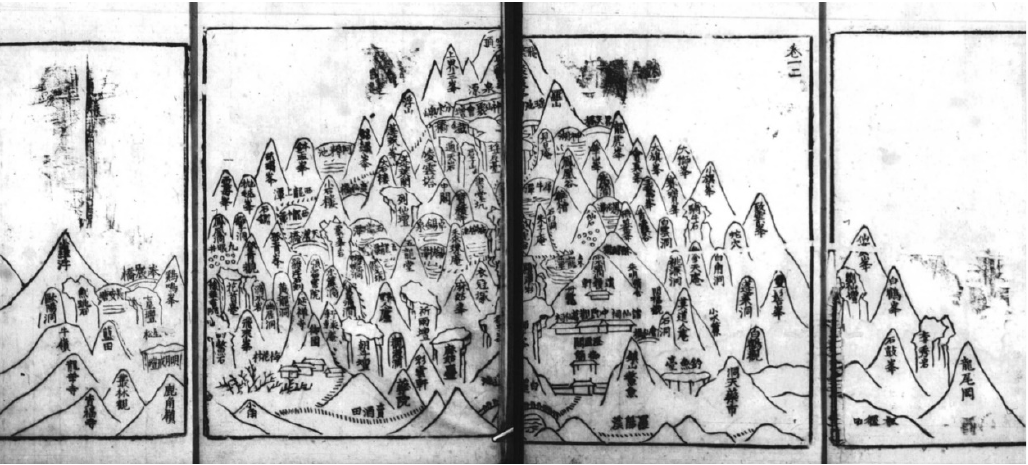
Figure 2. Panorama of the Luofu Mountains in Huang Zuo’s Luofu shan zhi , 1552. Woodblock print. After Huang Zuo, Luofu shan zhi , 1.1b-3a.